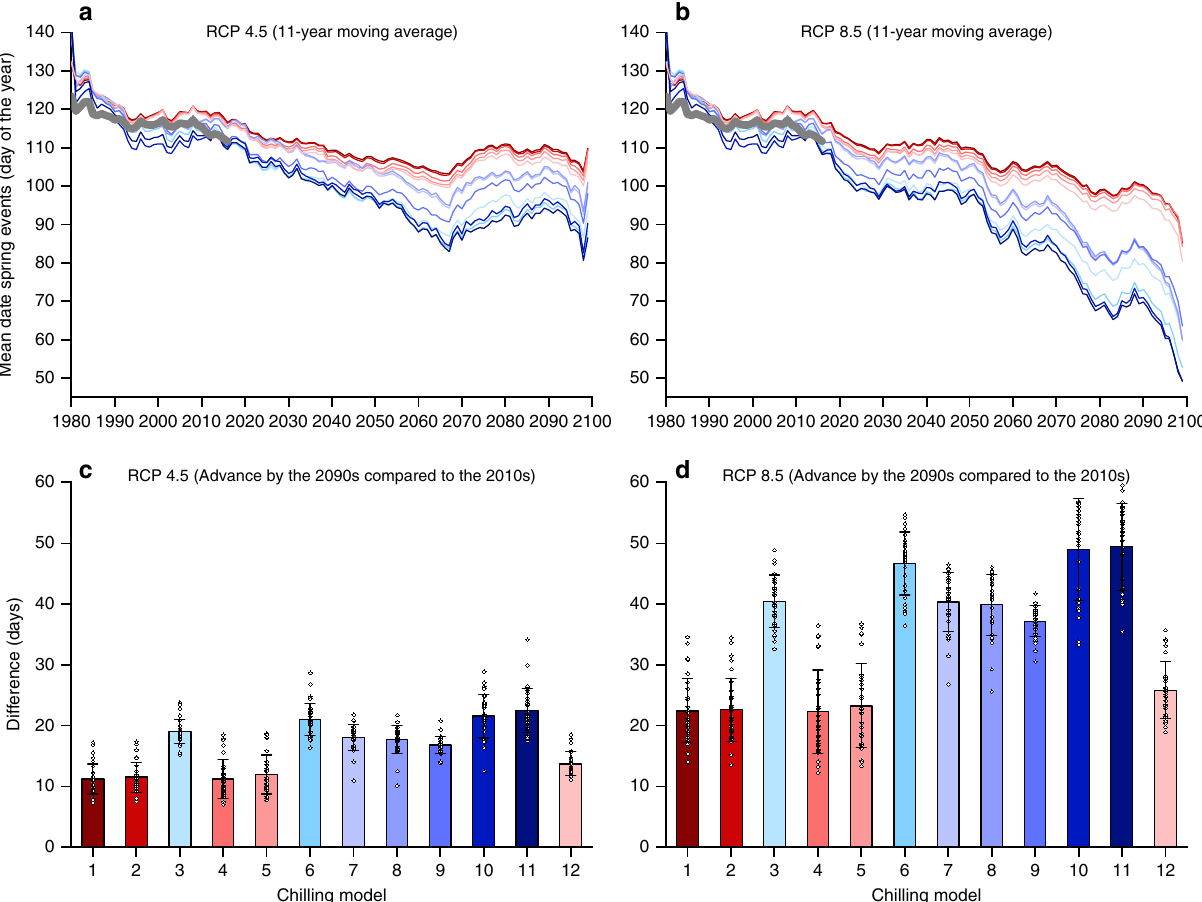
Fig. 4 Changes in spring phenology averaged for all species and stations for 2019 – 2099. Spring phenological events were simulated using linear regression between chilling accumulations based on the 12 chilling models (from 1 November to the onset of spring events) and the heat requirement (accumulated temperature >0 °C from 1 January to the onset of spring events) for all records. The observed (thick gray line) and simulated trends across spring events of all species over 1980 – 2018 are shown. Red colors represent valid chilling models (C 1 , C 2 , C 4 , C 5 , and C 12 ), and blue colors represent invalid models. a An 11-year moving average of spring phenological events under Representative Concentration Pathways (RCP) 4.5. b An 11-year moving average of spring phenological events under RCP 8.5. c Advance in spring events by the 2090s compared to the 2010s under RCP 4.5. d Advance in spring events by the 2090s compared to the 2010s under RCP 8.5. Error bars in ( c ) and ( d ), mean values± SD ( n = 30